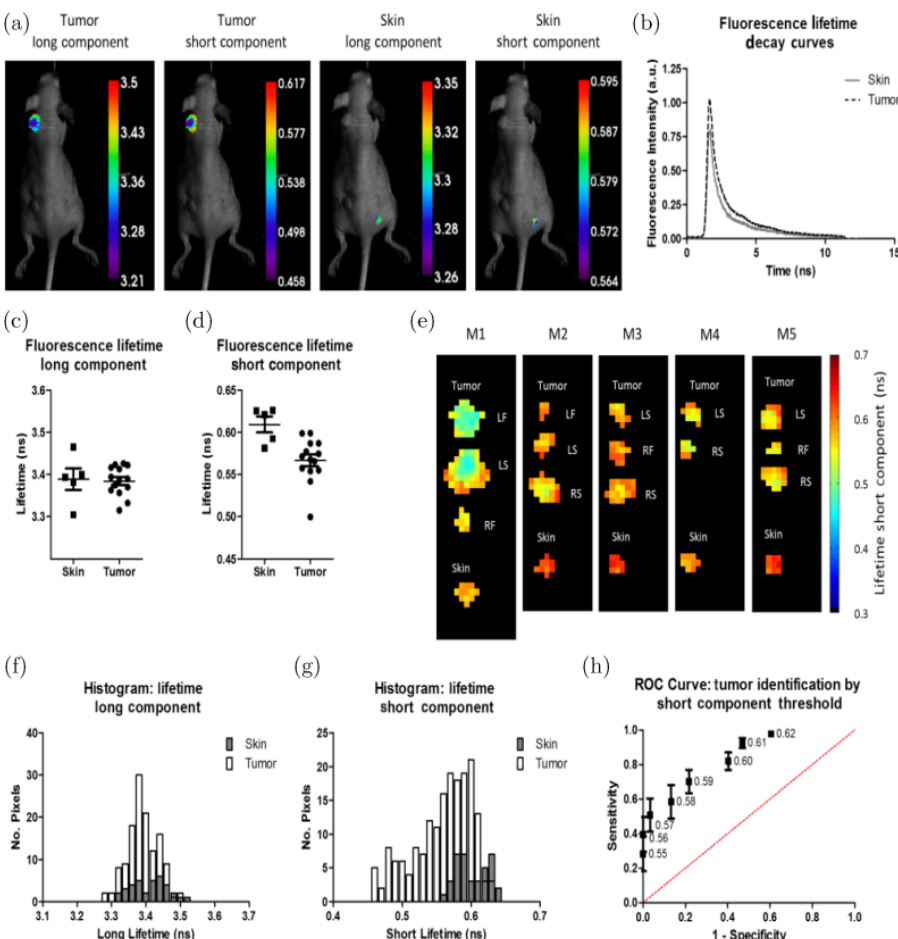
Fig. 7. (a) Representative mouse images showing the lifetime of a tumor region and an uninvolved skin region. (b) Representative FLT decay. (c) Average FLT long component for skin and tumor. (d) Average FLT short component for skin and tumor, p ¼ 0 : 004. (e) Lifetime maps for each pixel for tumors and skin. Tumors exhibited shorter lifetimes with the more central region containing the shortest lifetimes. Tumor locations are indicated as left °ank (LF), left shoulder (LS), right °ank (RF), and right shoulder (RS). (f) Histogram of long lifetime component for each pixel. (g) Histogram for short lifetime component. (h) Receiver operating characteristic (ROC) curve showing the sensitivity and speci¯city for tumor identi¯cation using di®erent short lifetime thresholds (the data point labels).